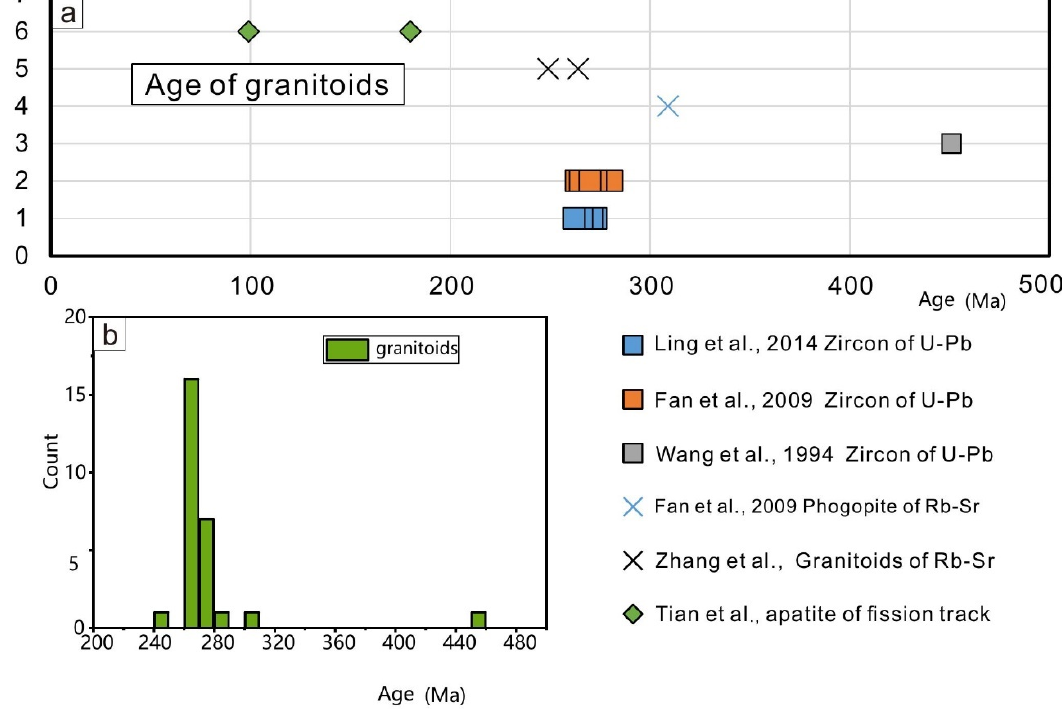
Figure 14. Age distribution characteristics of the granitoids. ( a ) Single age distribution characteristics corresponding to different studies. ( b ) Stack histograms of all ages. [4,24,25,34,45–47].